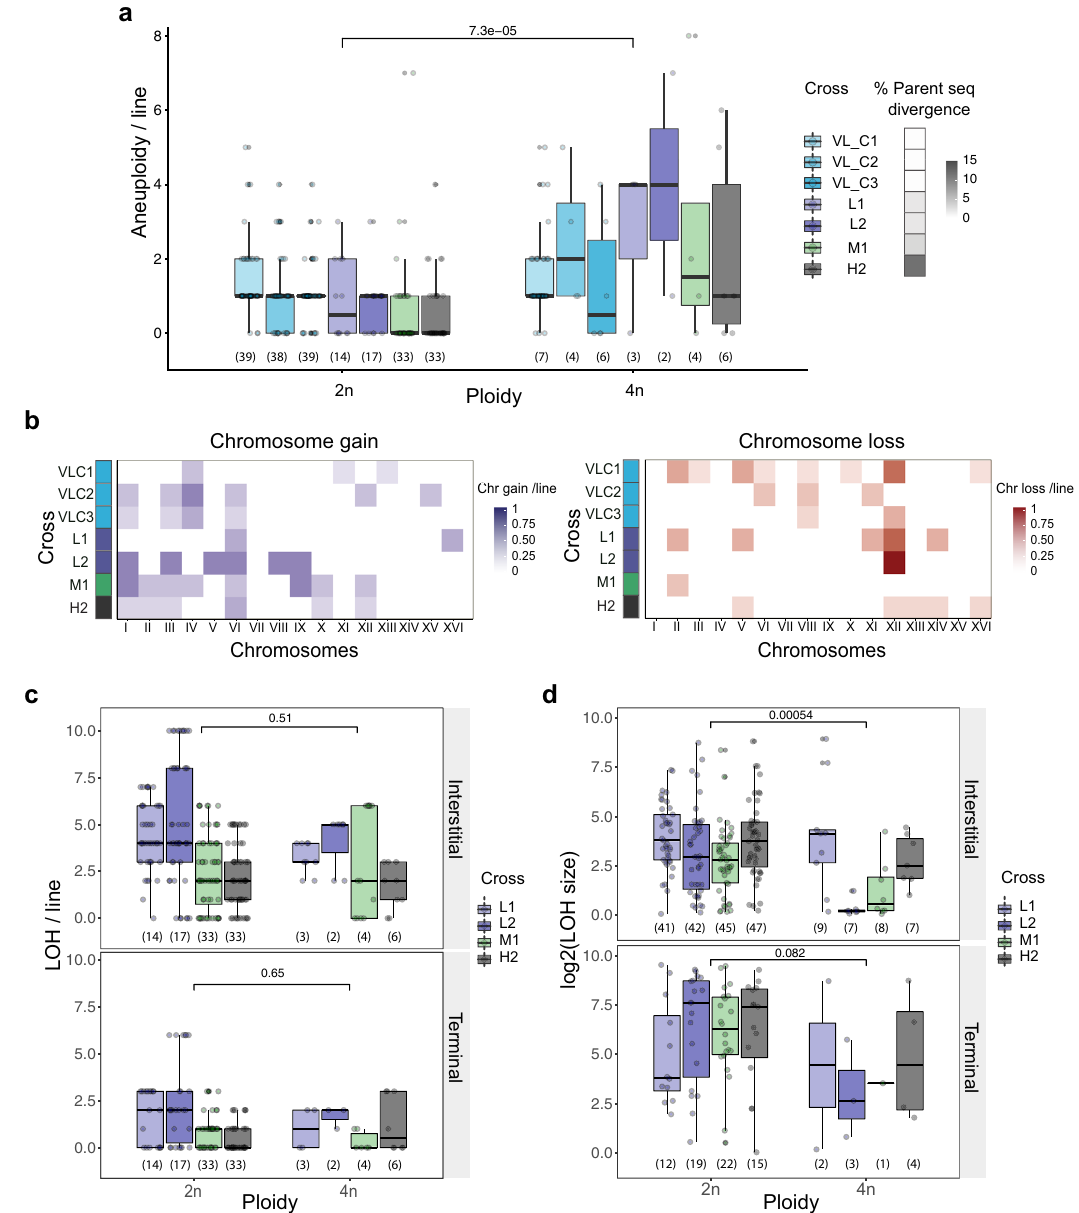
Fig. 4 Tetraploid lines display increased genomic variability compared to diploids. a Aneuploidy frequency increases with ploidy in intra-lineage VL_C crosses and hybrids. b Patterns of chromosome gain (left panel) and loss (right panel) in tetraploid intra-lineage VL_C crosses and hybrids. c Loss of heterozygosity (LOH) rate in tetraploids compared to diploid hybrids. d Interstitial and terminal LOH segment sizes in tetraploids compared to diploid hybrids. P values from a two-sided Mann – Whitney – Wilcoxon test are shown. Numbers in parentheses represent the number of biologically independent lines ( a and c ) or independent LOH segments ( d ). For all boxplots the bold center line corresponds to the median value, the box boundaries correspond to the 25th and the 75th percentile, the whiskers correspond to 1.5 times the interquartile range, minimum and maximum values correspond to the minima and maxima and the dots correspond to the individual data